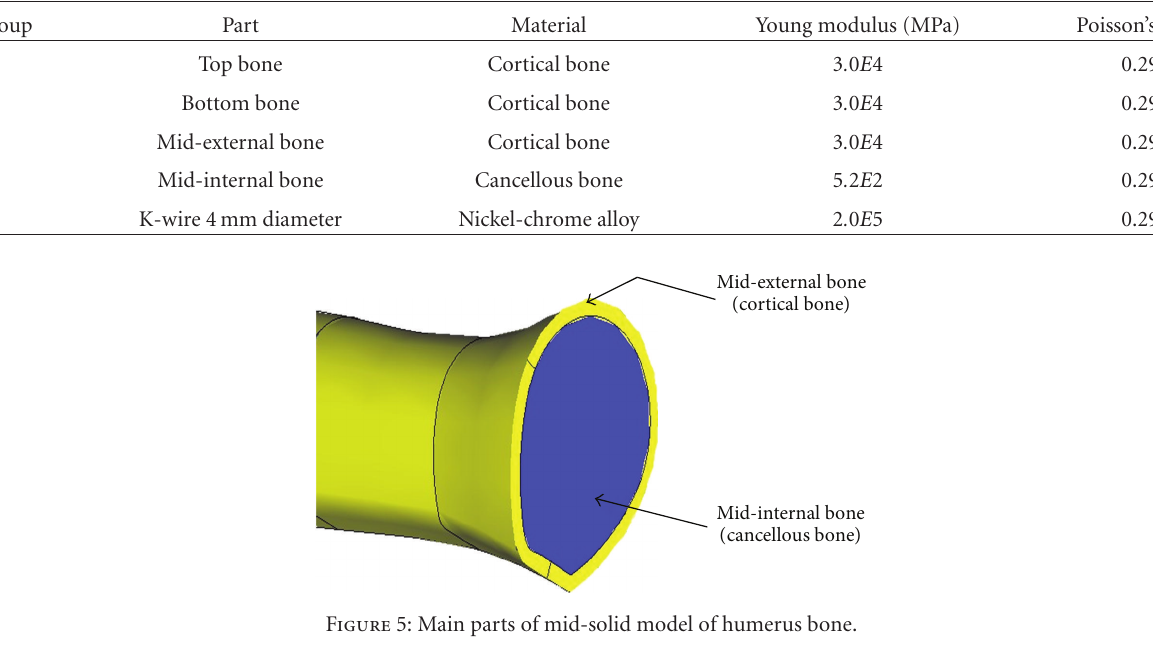
Table 1: Assigned material properties on the developed solid model.